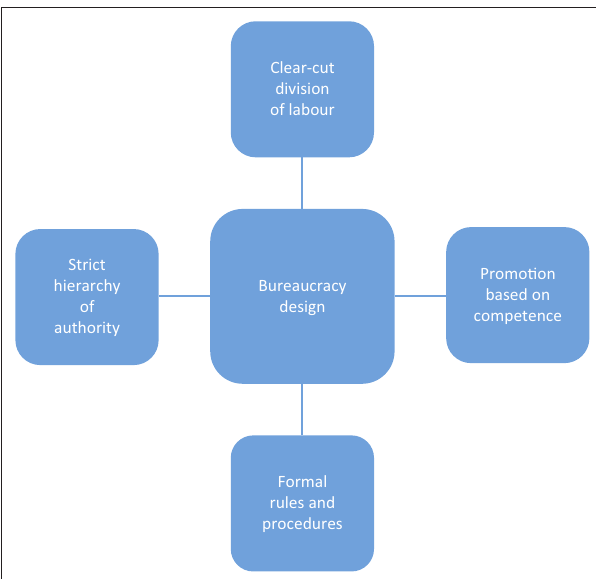
Figure 1 for more clarification of work procedure design.